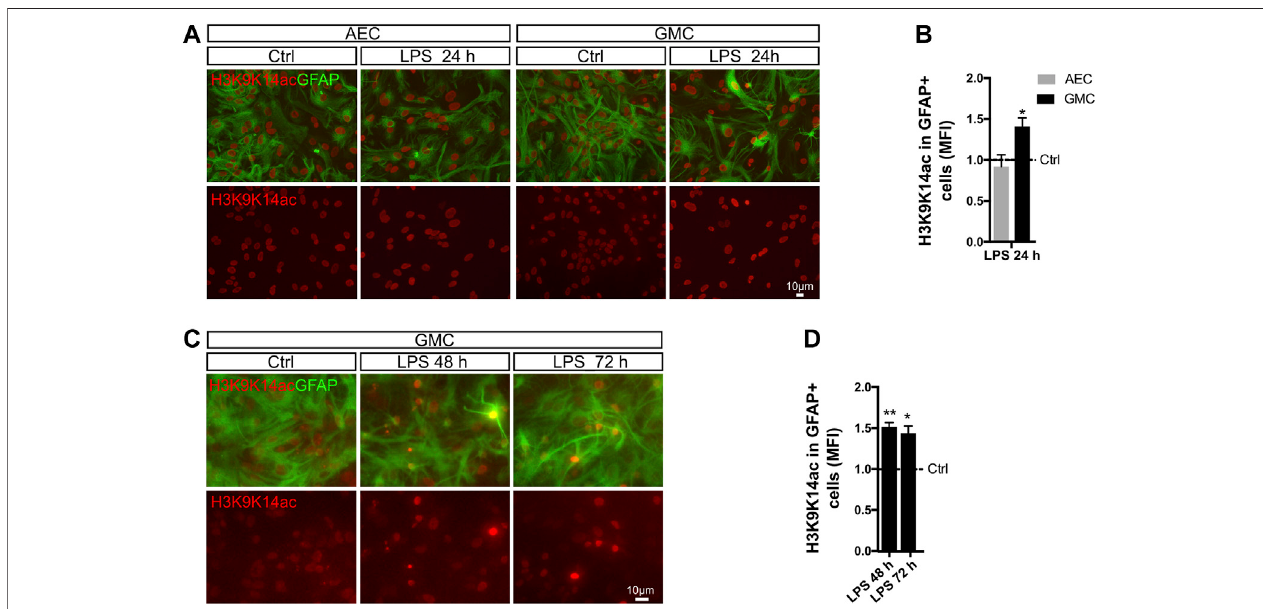
FIGURE 4 | Histone acetylation in astrocytes is microglia-dependent. (A) Astrocyte-enriched cultures (AECs) or glial mixed cultures (GMCs) were incubated with LPS for 24 h in reduced-serum medium. To address changes in the global levels of histone 3 acetylation in astrocytes in response to LPS, we performed double immuno fl uorescence staining for GFAP and acetylated lysins 9 and 14 of histone 3 (H3K9K14ac). (B) Graph showing the mean fl uorescence intensity (MFI) for H3K9K14ac in the nuclei of GFAP-positive cells after normalizing to the control (Ctrl (cid:2) 1). Each time point was compared to the respective control (no LPS) using one-sample t -test with the statistical signi fi cance represented as * p < 0.05. n (cid:2) 3 – 6. (C) Glial mixed cultures (GMCs) were incubated with LPS during the indicated time points in reduced-serum medium. To address changes in the global levels of histone 3 acetylation in astrocytes in response to LPS, we performed double immuno fl uorescence staining for GFAP and acetylated lysins 9 and 14 of histone 3 (H3K9K14ac). (D) Graph showing the mean fl uorescence intensity (MFI) for H3K9K14ac in the nuclei of GFAP-positive cells after normalizing to the control (Ctrl (cid:2) 1). Each time point was compared to the respective control (no LPS) using one- sample t -test with the statistical signi fi cance represented as * p < 0.05, ** p < 0.01; n (cid:2)